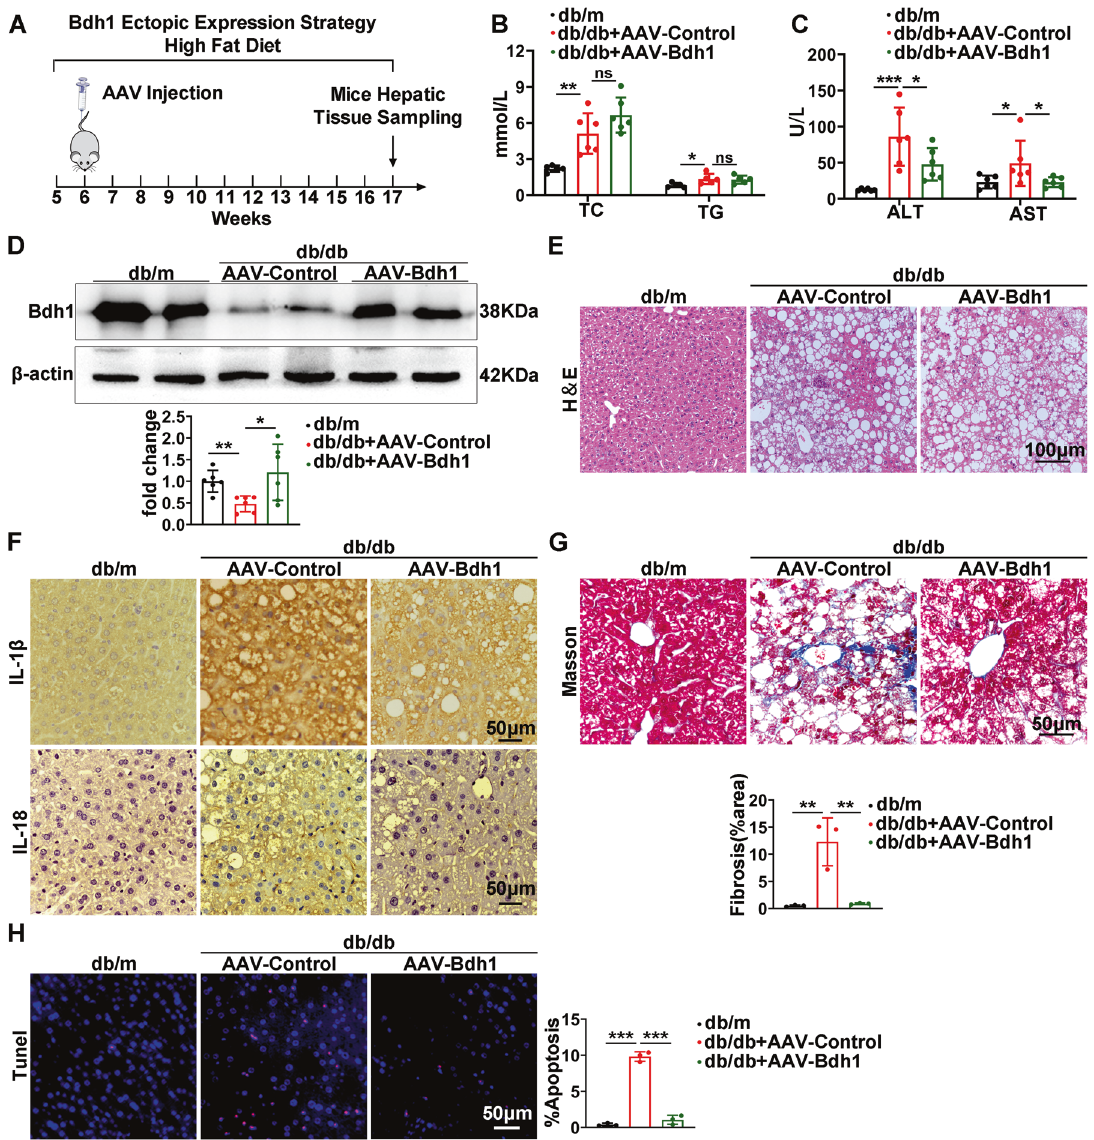
Fig. 7 AAV-mediated Bdh1 hepatic expression alleviated the progression of MAFLD. A A schematic representation of the Bdh1 ectopic expression strategy in db/db mice. B Serum levels of TG and TC in db/m and db/db mice with vector or AAV-Bdh1 injection ( n = 6 per group). C Serum levels of ALT and AST in db/m and db/db mice with vector or AAV-Bdh1 injection ( n = 6 per group). D Representative western blots showing the protein level of Bdh1 in livers from indicated groups ( n = 5 per group). ( F – H ) The representative photomicrographs of H&E ( E ), IHC (IL-1 β , IL-18) ( F ), Masson ( G ), and Tunel staining ( H ) show the pathological changes in livers from indicated groups. Bar: 100 μ m in E, 50 μ m in F – H . All results are representative of three independent experiments. Values are presented as mean ± SD. * P < 0.05; ** P < 0.01; *** P <